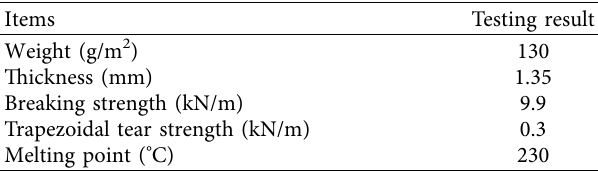
Figure 1: Nonwoven polyester geotextile. Table 1: Mechanical properties of nonwoven polyester geotextile.